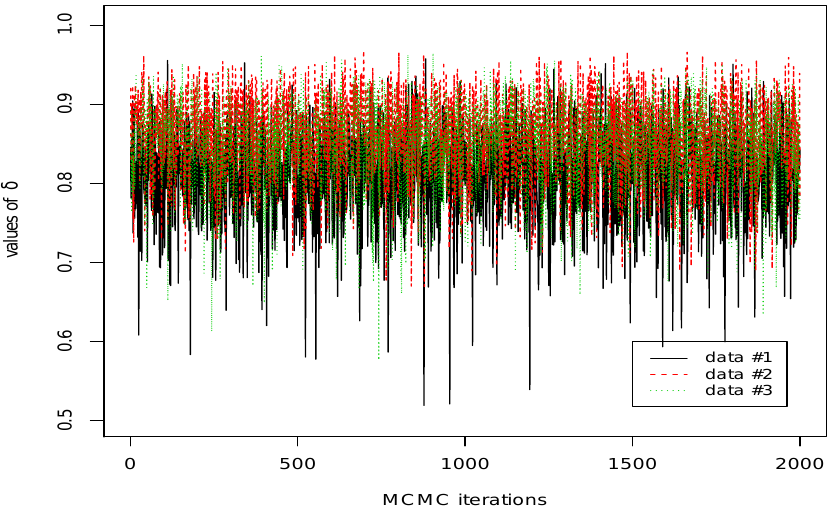
Figure 15. Comparison of coverage